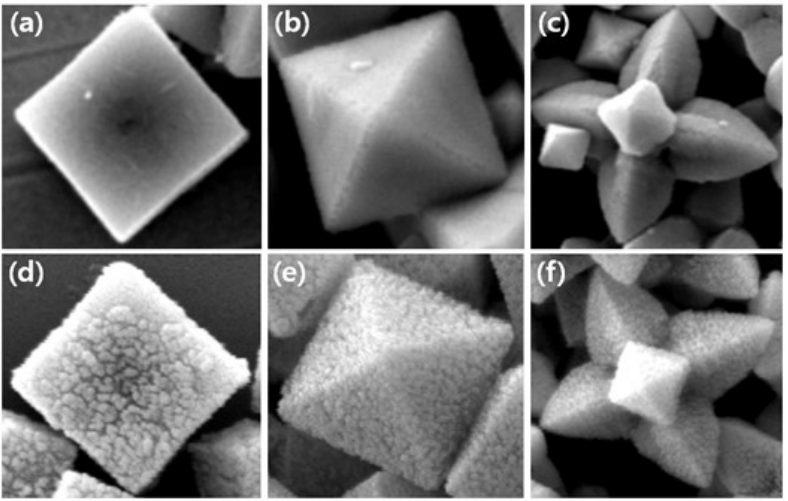
O; ( b ) octahedral Cu 2 O; and ( f ) hexapod Au/Cu 2